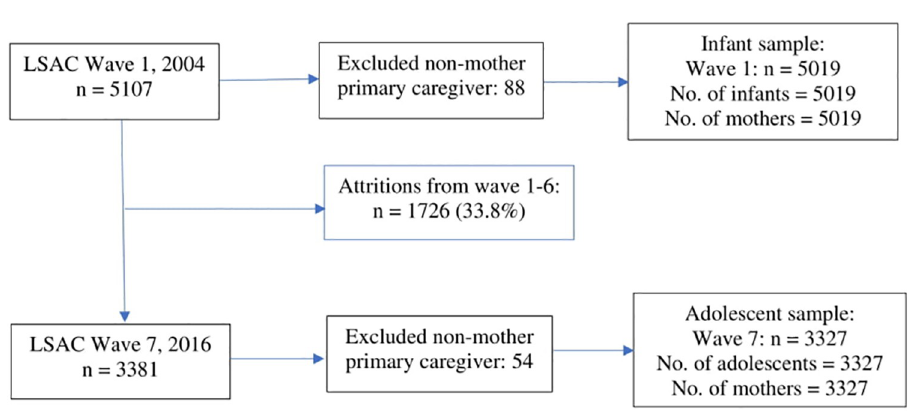
Fig 1. Longitudinal participant numbers of the study after exclusions and